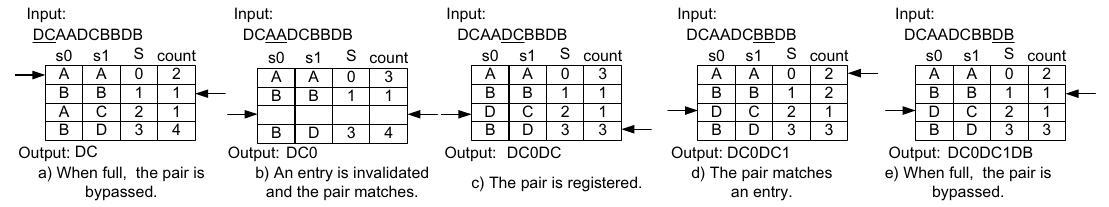
Figure 8. Example of a compression mechanism using the lazy compression technique.